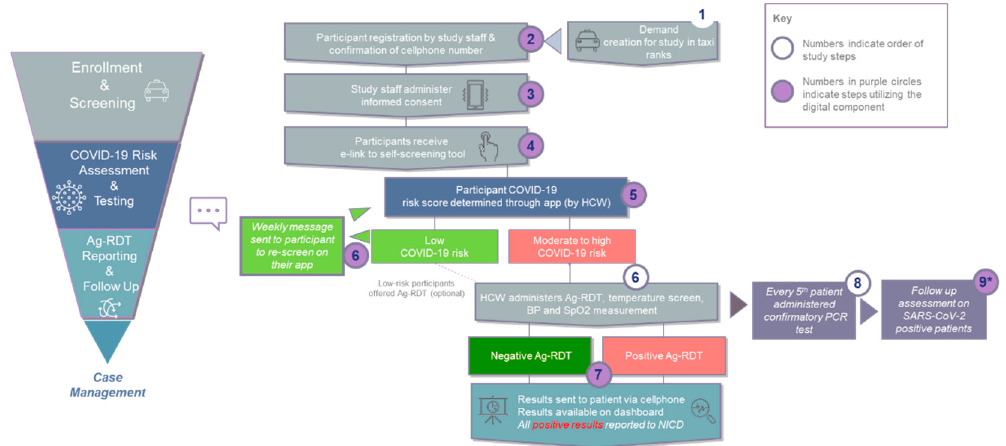
Figure 1. Overall study process. * Participants whose PCR results were discordant from their Ag-RDT results were notified and updated results were sent to NICD. Ag-RDT, antigen-detecting rapid diagnostic test; BP, blood pressure; HCW, healthcare worker; NICD, National Institute for Communicable Diseases; PCR, polymerase chain reaction.